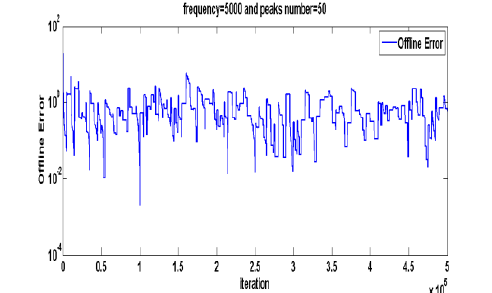
Figure 11. Offline error for proposed algorithm in frequency = 5000 and peak number =